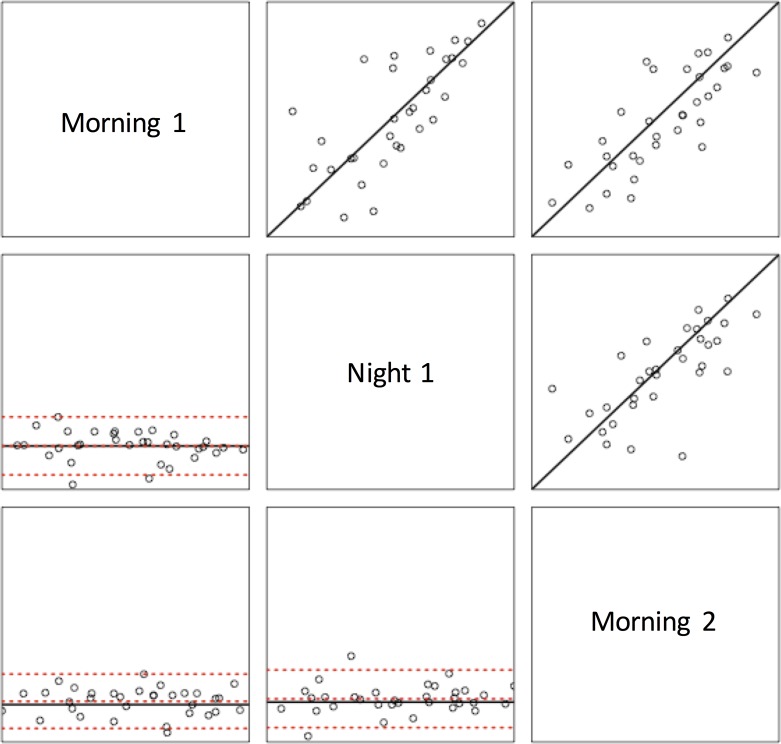
A matrix of plots illustrating the agreement of HRV between three time points.The upper right panels consist of scatterplots with identity line (45° line though the origin). The lower left panels consist of Bland-Altman plots with confidence bounds and bias (dotted red line) and the horizontal black line passing through the origin. The confidence bounds show the mean of the difference between time points plus or minus twice of the standard deviation of the difference.